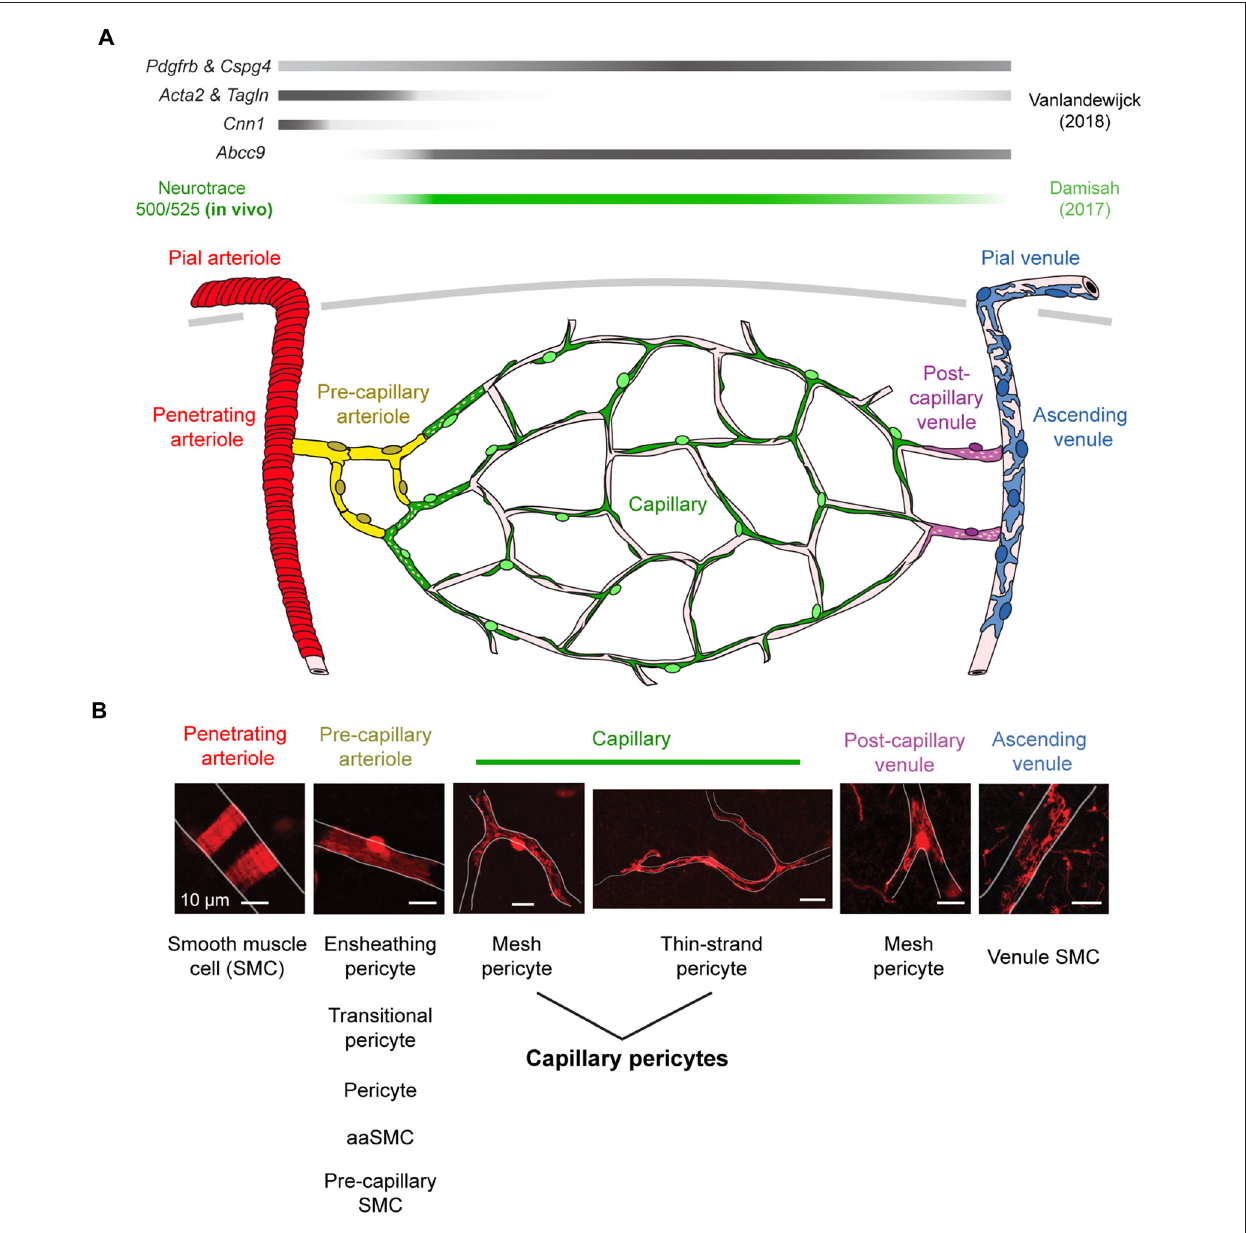
FIGURE 2 | Mural cell heterogeneity in the adult mouse cerebrovascular network. (A) (Top) Mural cell gene expression in different zones of the microvasculature in cerebral cortex. Adapted from Vanlandewijck et al. (2018). Neurotrace 500/525 is specifically taken up by capillary pericytes, providing a cell-specific fluorescent label for in vivo imaging (Damisah et al., 2017). (Bottom) Schematic depicting mural cells in seven microvascular zones from pial arterioles to pial venule of cerebral cortex. (B) (Top) Representative images showing morphology of mural cells in five zones below the cortical surface. All scale bars are 10 µ m, except the penetrating venule image, which is 50 µ m. Adapted from Hartmann et al. (2015a) and Grant et al. (2017). (Bottom) The evolving nomenclature for each cell type. Note that naming of mural cells in the pre-capillary arteriole zone is not universally agreed upon and has become a source of